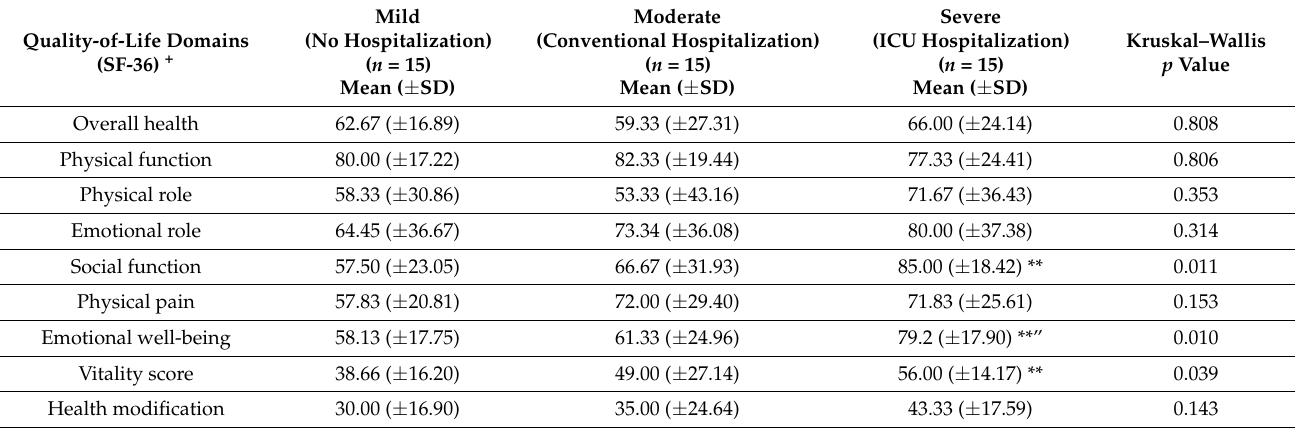
Table 4. Quality of life of patients with mild, moderate, or severe COVID-19 6–9 months